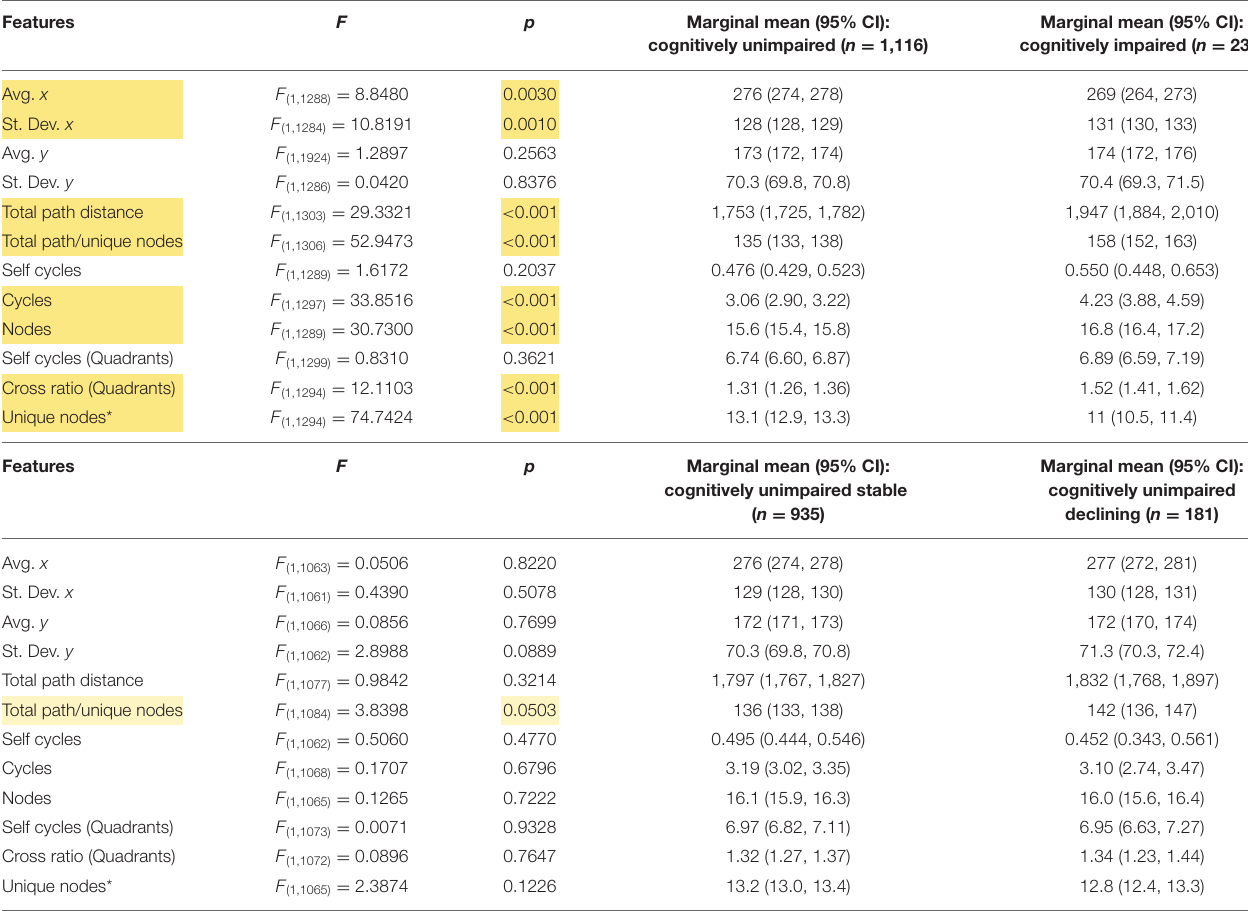
TABLE 2 | ANCOVA models for features against two binary comparisons.